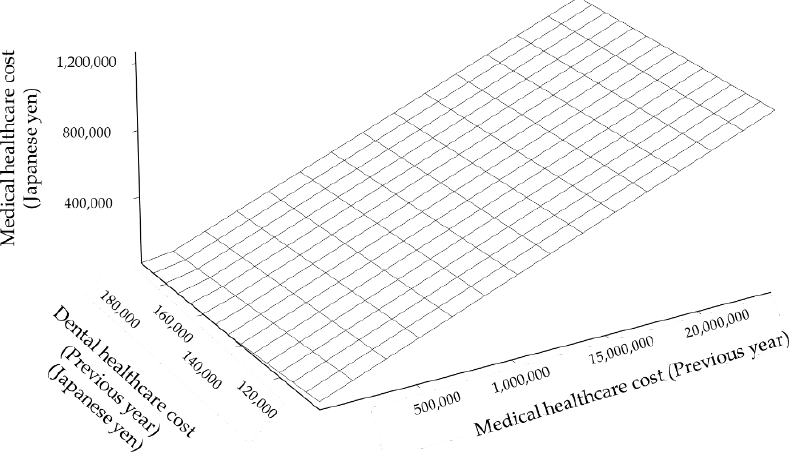
Figure 6. Response surface of the prediction of the medical healthcare cost by the medical healthcare cost of the previous year and dental healthcare cost of the previous year.